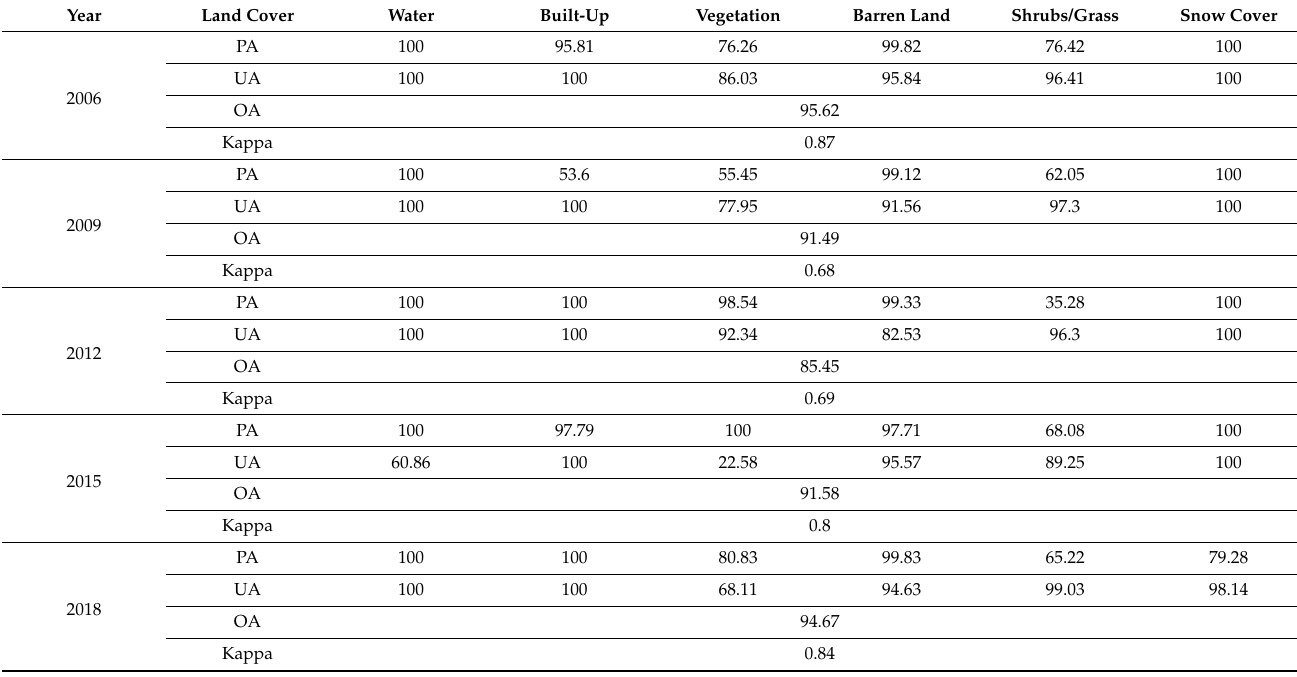
Table 3. Error matrix of the land cover classification from 2006 to